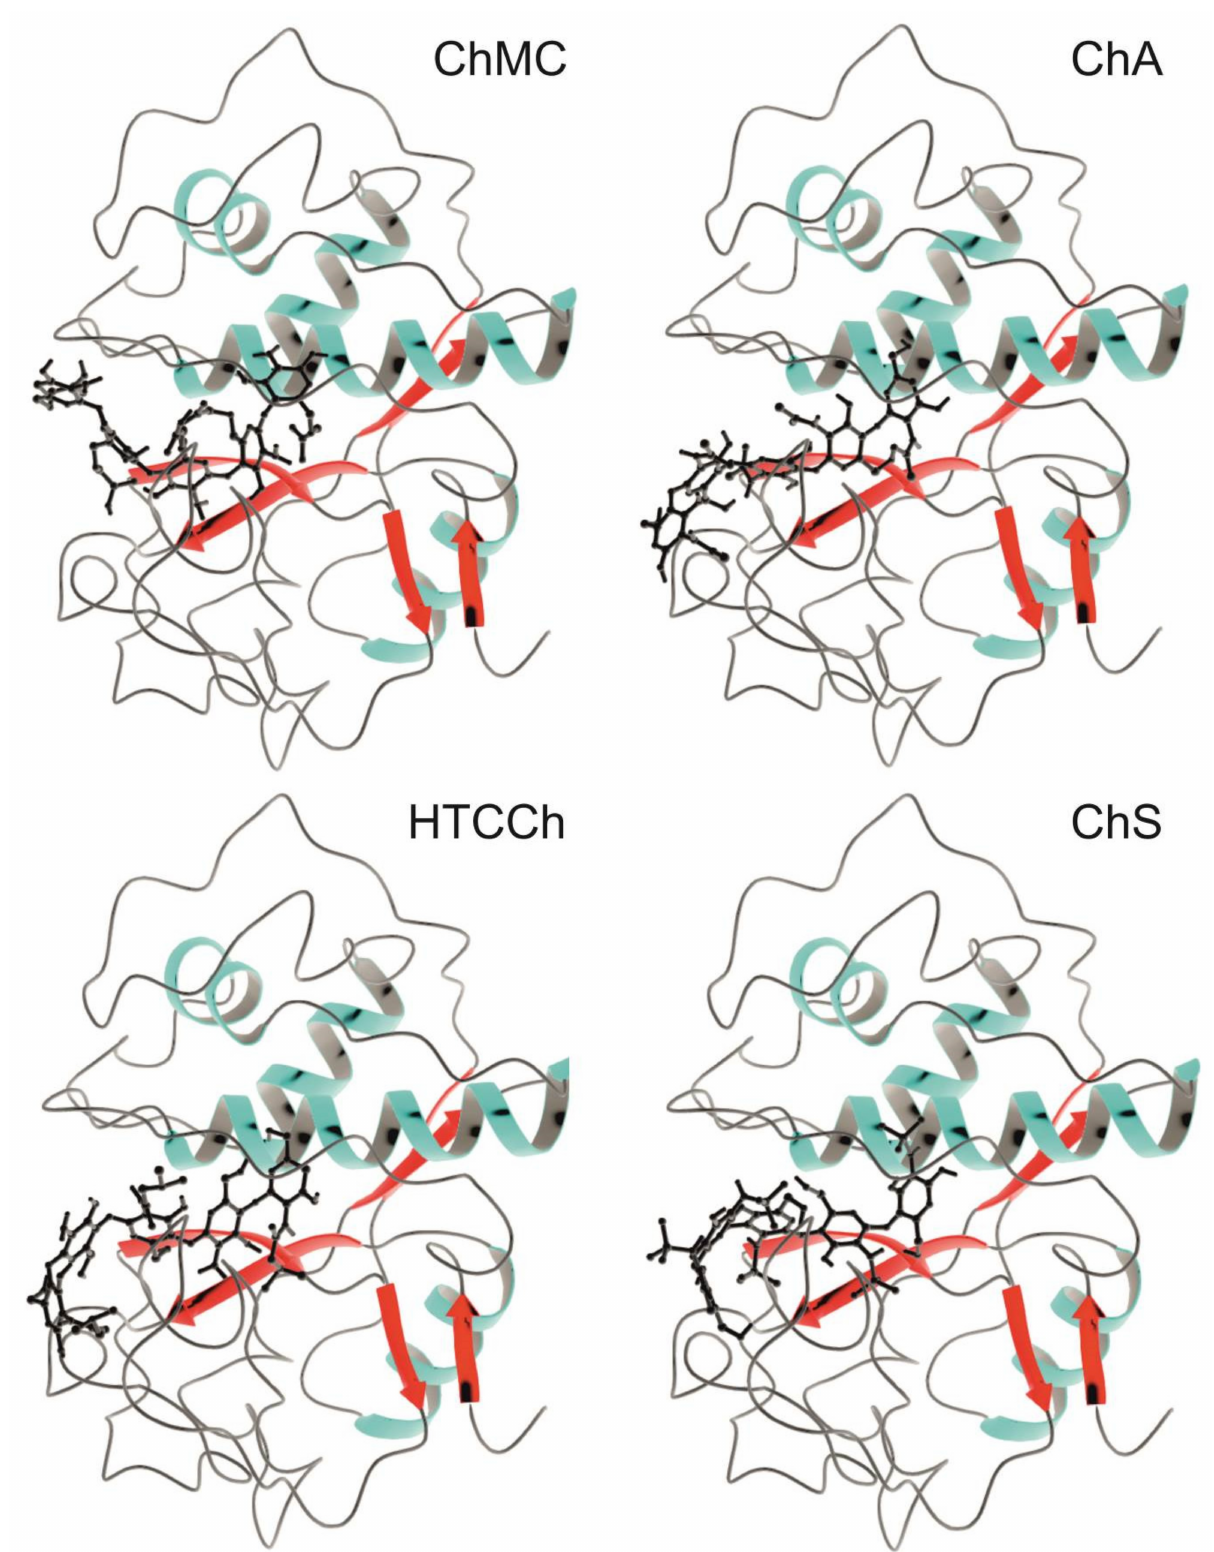
Figure 2. Molecular docking results. Topology of bromelain complexes with ChMC, HTCCh, ChS, and